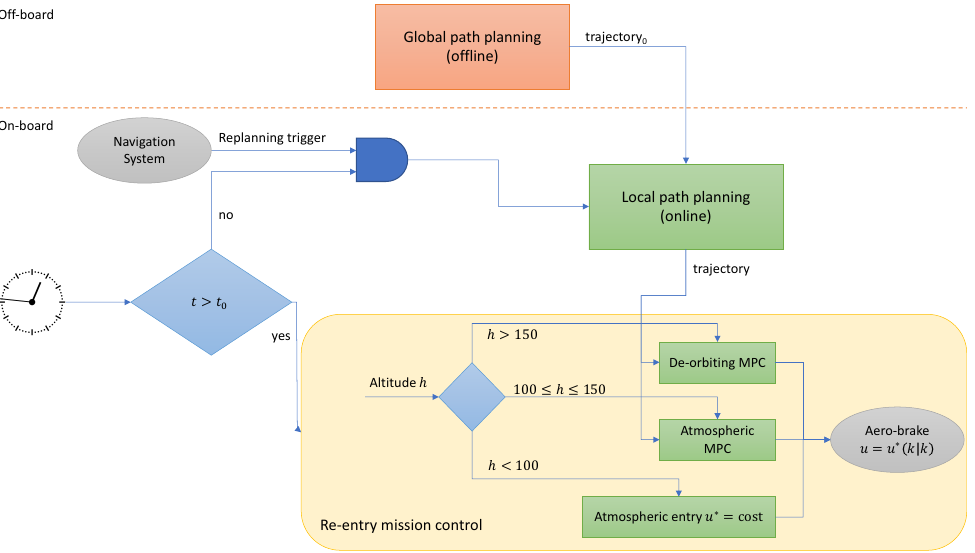
Figure 1. Guidance and control algorithm